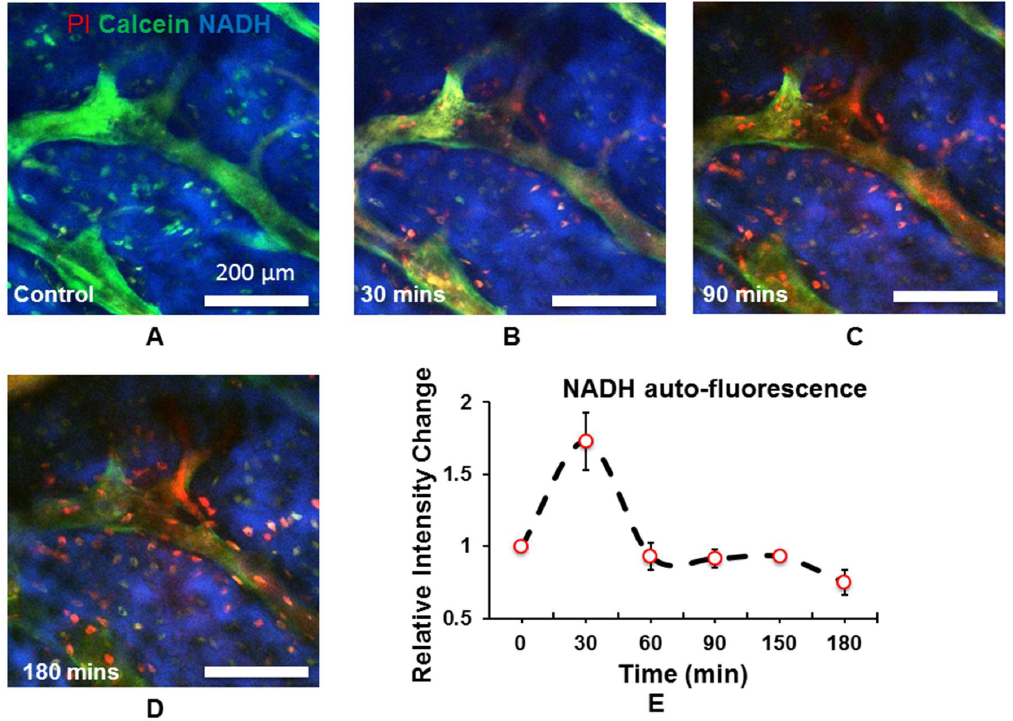
Figure 5. Intensity quantification of NADH auto-fluorescence after photo-thrombosis: ( A – D ) NADH auto-fluorescence (blue) changes inside the bone at the different time point ( E ) quantitative analysis of NADH auto-fluorescence